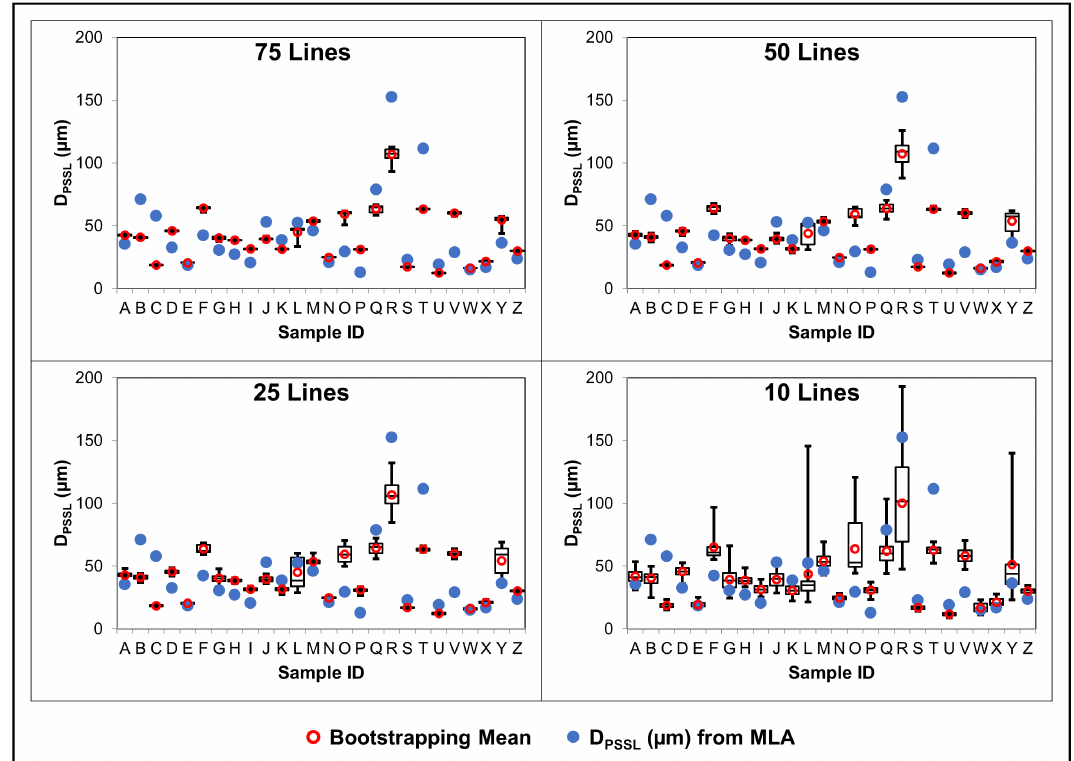
Figure 20. Box-and-whisker plot for the 26 tiles analyzed showing the bootstrapping results for combined Cu-sulfides using 75, 50, 25, and 10 random LIBS lines per sample. The boxes outline the upper and lower quartiles, and the whiskers represent the minimum and maximum values. These are compared with the mineral liberation analysis (MLA) results (blue dots) on the same tiles.